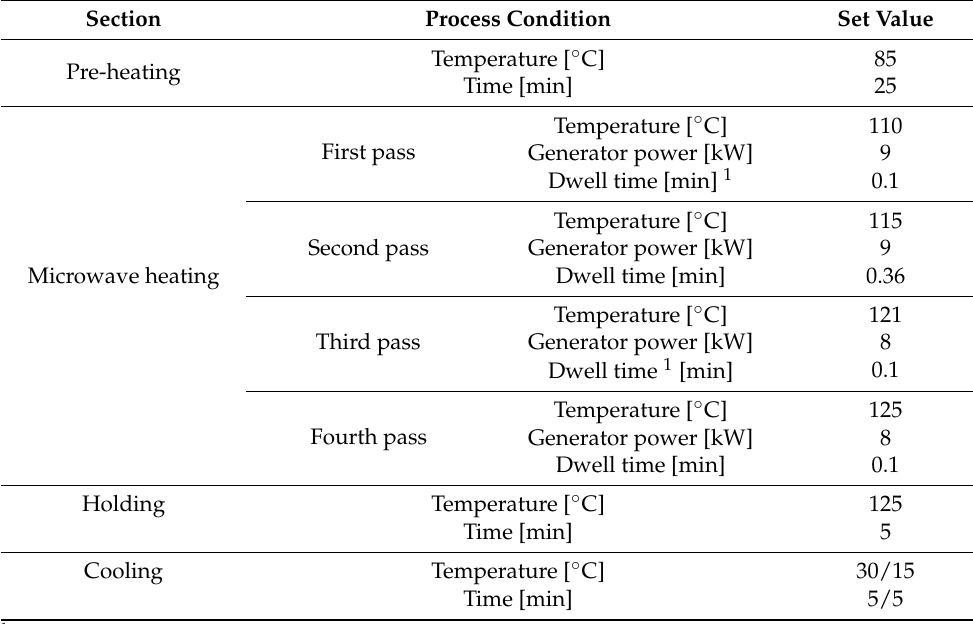
Table 2. Process parameter settings for MATS-B experimental